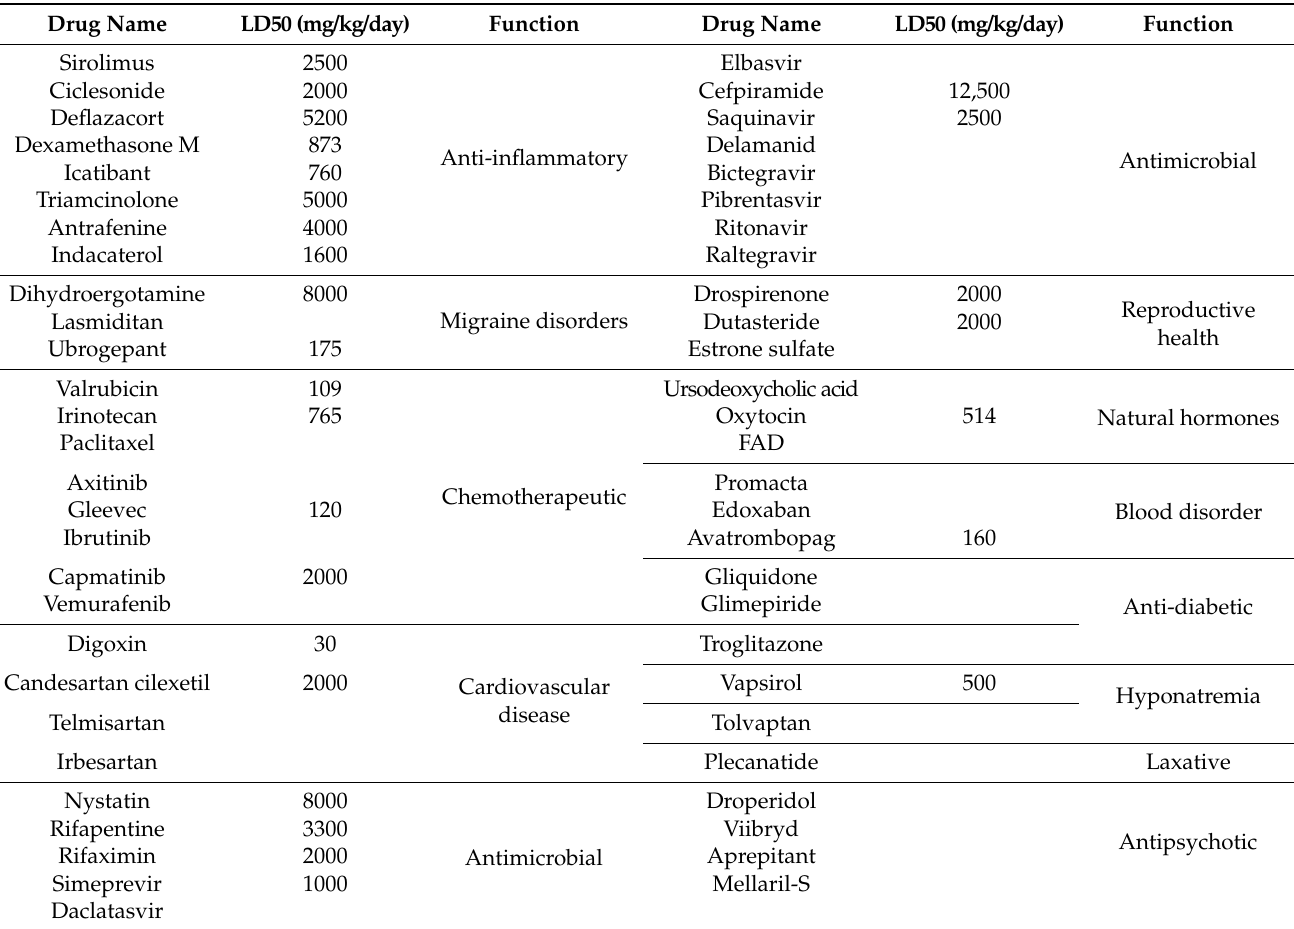
Table 1. The list of ligands refined according to their toxicity, structural and functional